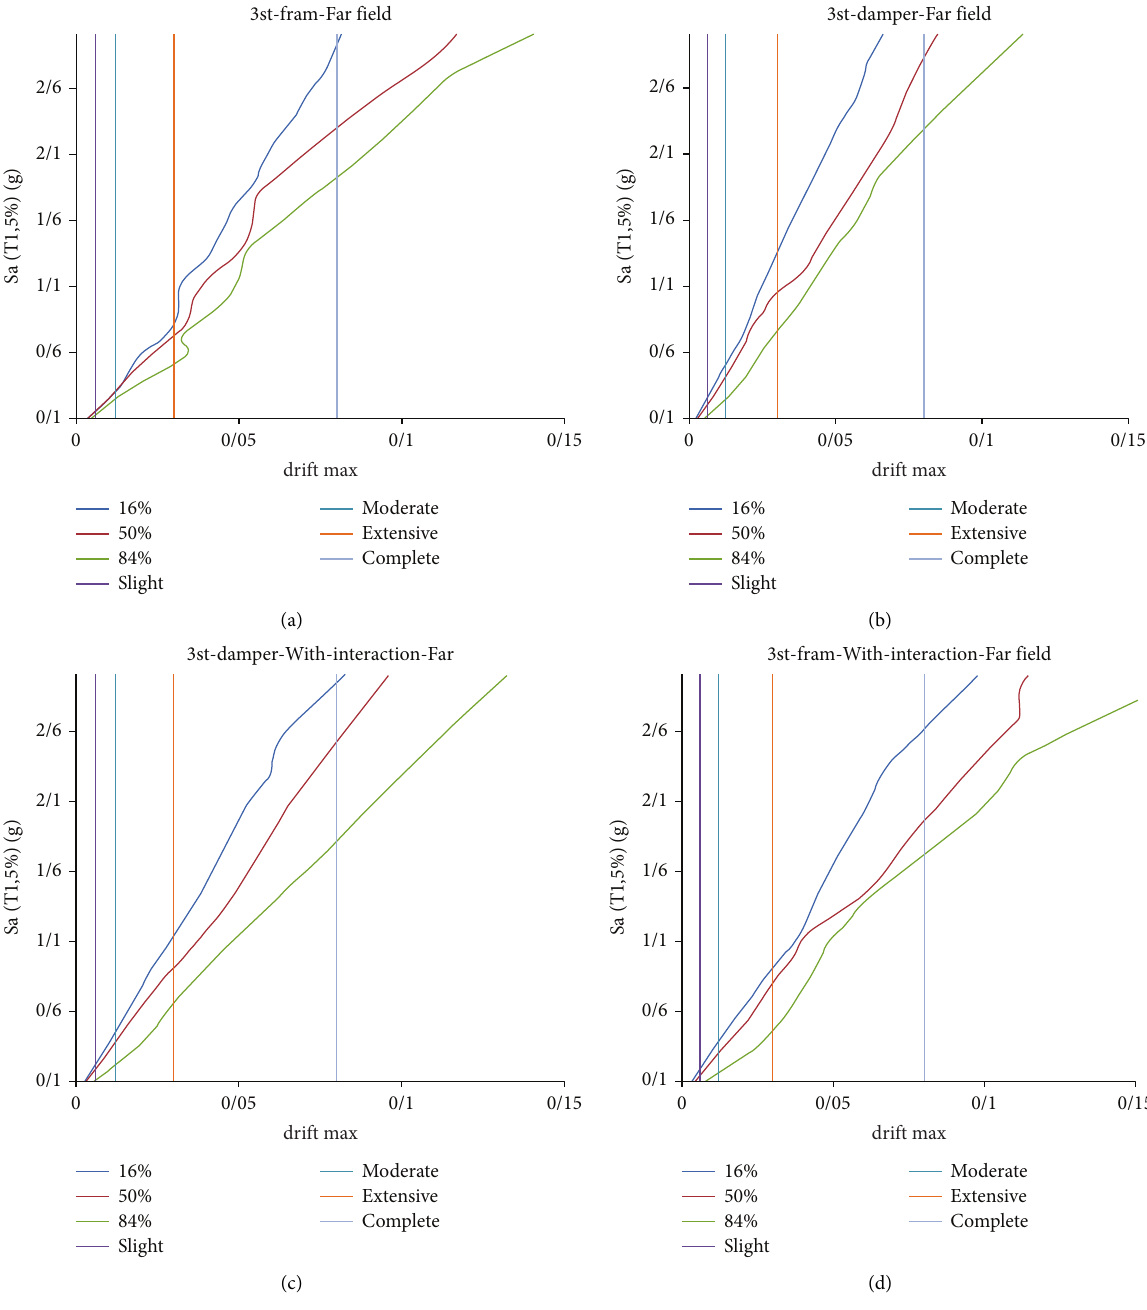
Figure 7: Summary of IDA curves for 16%, 50%, and 84% percentiles in 3-story ordinary moment resisting frame affected by far-field earthquakes. Examined cases: (a) with damper without considering SSI; (b) without Damper and SSI effect; (c) with damper and considering SSI; (d) without damper but considering SSI